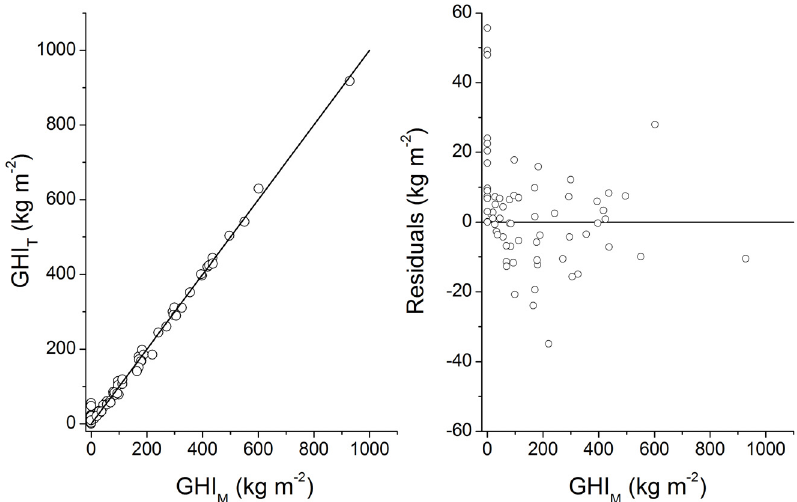
Figure 23. Gas hydrate inventories ( GHI in kg m − 2 ) within the GHSZ calculated by individual runs of the transport-reaction model ( GHI , Equation (32)] for fully compacting margin sediments (see legend of Figure 18 for [ GHI T further information).